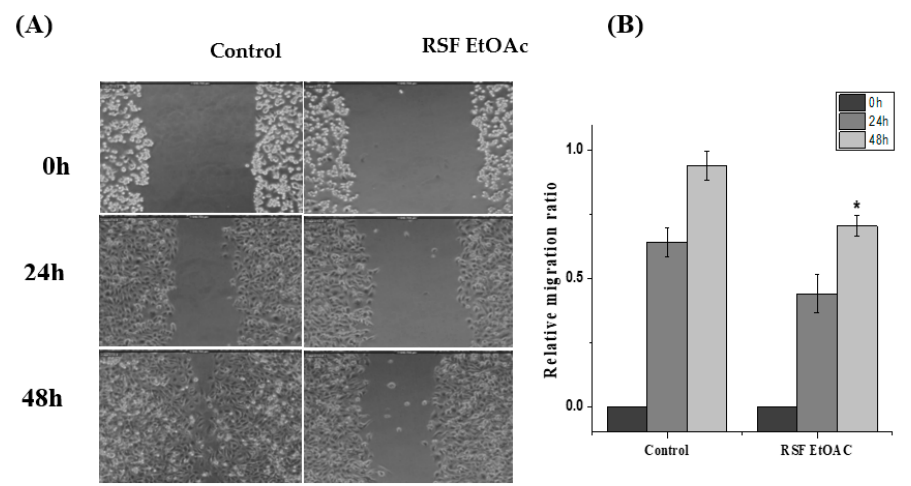
Figure 5. E ff ects of RSF EtOAC on MDA-MB-231 cell migration. ( A ) Images of the wounded monolayer of MDA-MB-231 cells captured immediately after wounding (t = 0 h) and following an incubation time of 24 h or 48 h. Cells were untreated (control) or treated at IC 25 . ( B ) Cell migration rate was calculated as described in materials and method. Experiments were performed in triplicate, * p < 0.05, ** p < 0.01 vs. the control (Student’s two-tailed t -test).